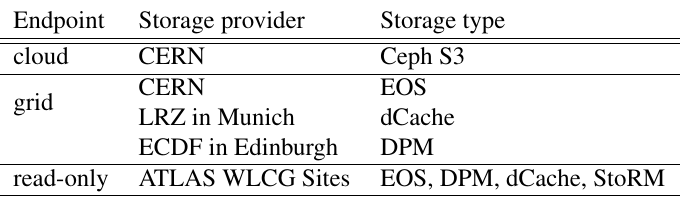
Table 1. Three Dynafed endpoints tested for